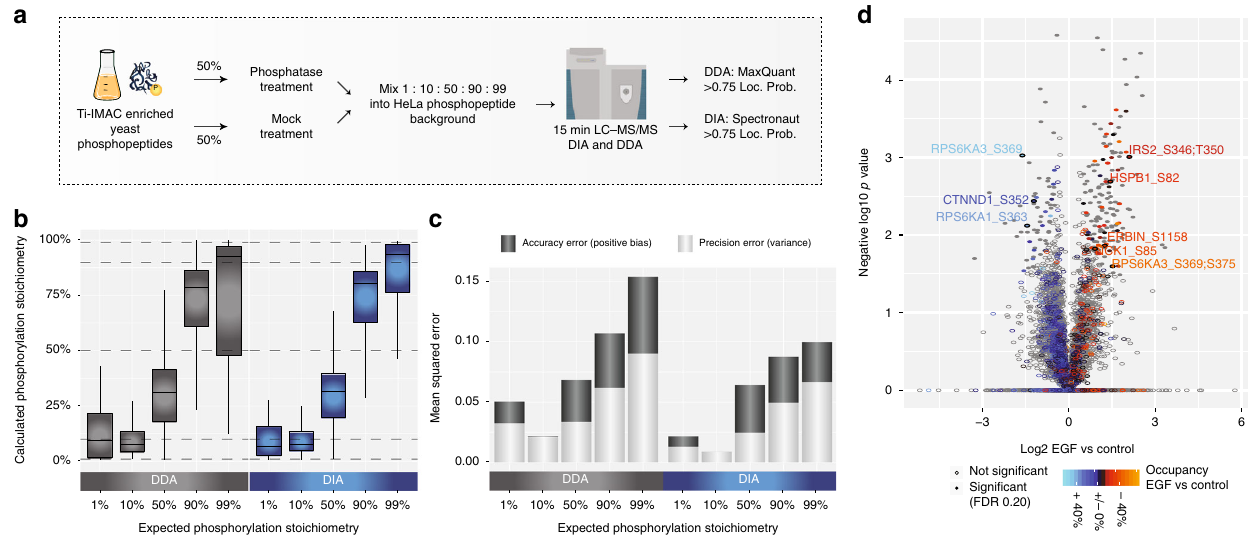
Fig. 4 Stoichiometry benchmark. a Experimental work fl ow for experiment with controlled ratios. b Boxplot of calculated phosphorylation stoichiometry with DDA and DIA from six independent measurements. Boxes mark the fi rst and third quantile, with the median highlighted as dash, and whiskers marking the minimum/maximum value within 1.5 interquartile range. Outliers are not shown. c Mean squared errors for calculated stoichiometries with DDA and DIA from six independent measurements were calculated as a sum of positive bias and variance for each method and all replicates. d Volcano plot analysis of calculated occupancies EGF vs. control from three independent measurements. Source data for this fi gure are provided as a Source Data fi